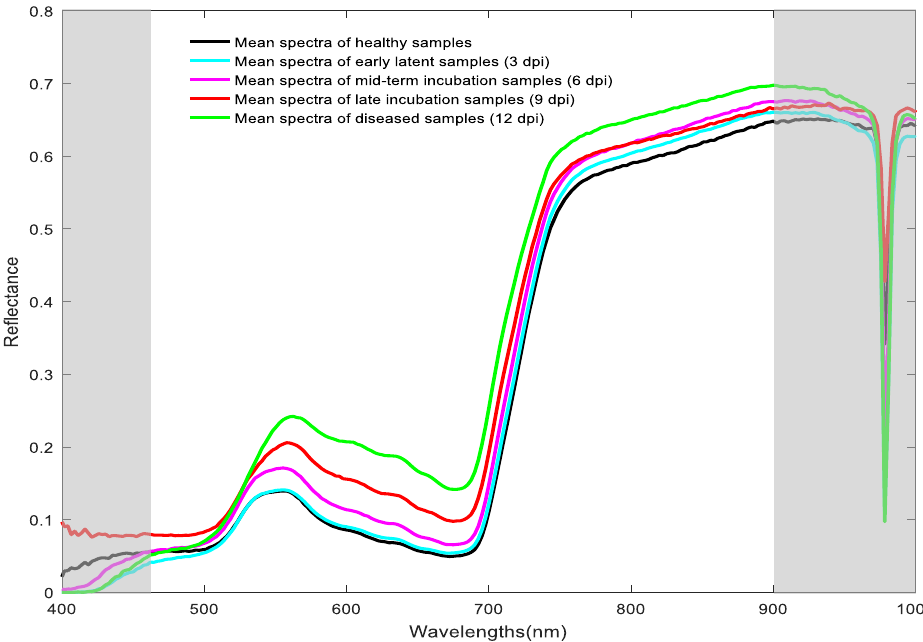
Figure 3. Mean spectral reflectance curves of wheat leaves with different days post-inoculation (dpi).